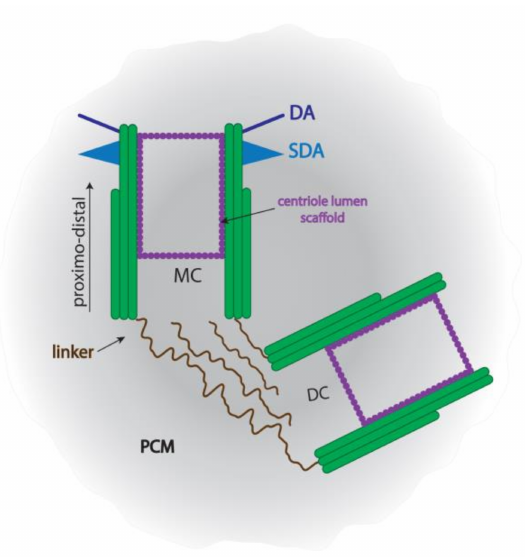
Figure 1. Depiction of a typical centrosome. The centriole pair is located in the center of the pericentriolar material (PCM). Mother and daughter centrioles, MC and DC, respectively, have a defined proximo-distal axis and are interconnected by linker proteins at their proximal ends. Distal and subdistal appendages, DA and SDA, respectively, extend from the distal end of the mother centriole. A centriole scaffold located at the inner wall of both centrioles stabilizes the